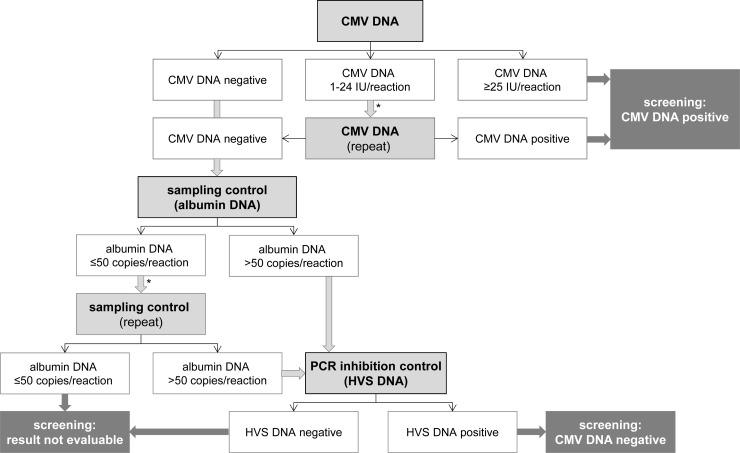
Flow chart of the cCMV screening algorithm.Buccal swabs were tested for the presence of CMV DNA. Samples that contained ≥25 IU CMV DNA/PCR reaction were considered as CMV DNA positive. Samples that were positive but contained <25 IU CMV DNA/PCR reaction were re-tested. For saliva samples that were tested negative in the initial or repeated CMV DNA, PCR internal controls (albumin, Herpesvirus saimiri (HVS)) were evaluated to exclude false negative results. *sample re-extraction and PCR black thin arrow: test result; light gray arrow: subsequent investigation; dark gray arrow: clinical report.